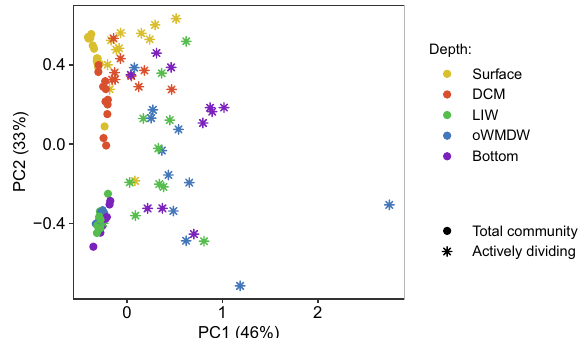
Figure 1. Principal Coordinates Analysis (PCoA) of prokaryotic communities based on weighted UniFrac distances. The variance explained is shown for each axis. Colours indicate depth and shapes indicate total versus actively dividing communities. DCM: deep chlorophyll maximum; LIW: Levantine intermediate water; oWMDW: old western Mediterranean deep